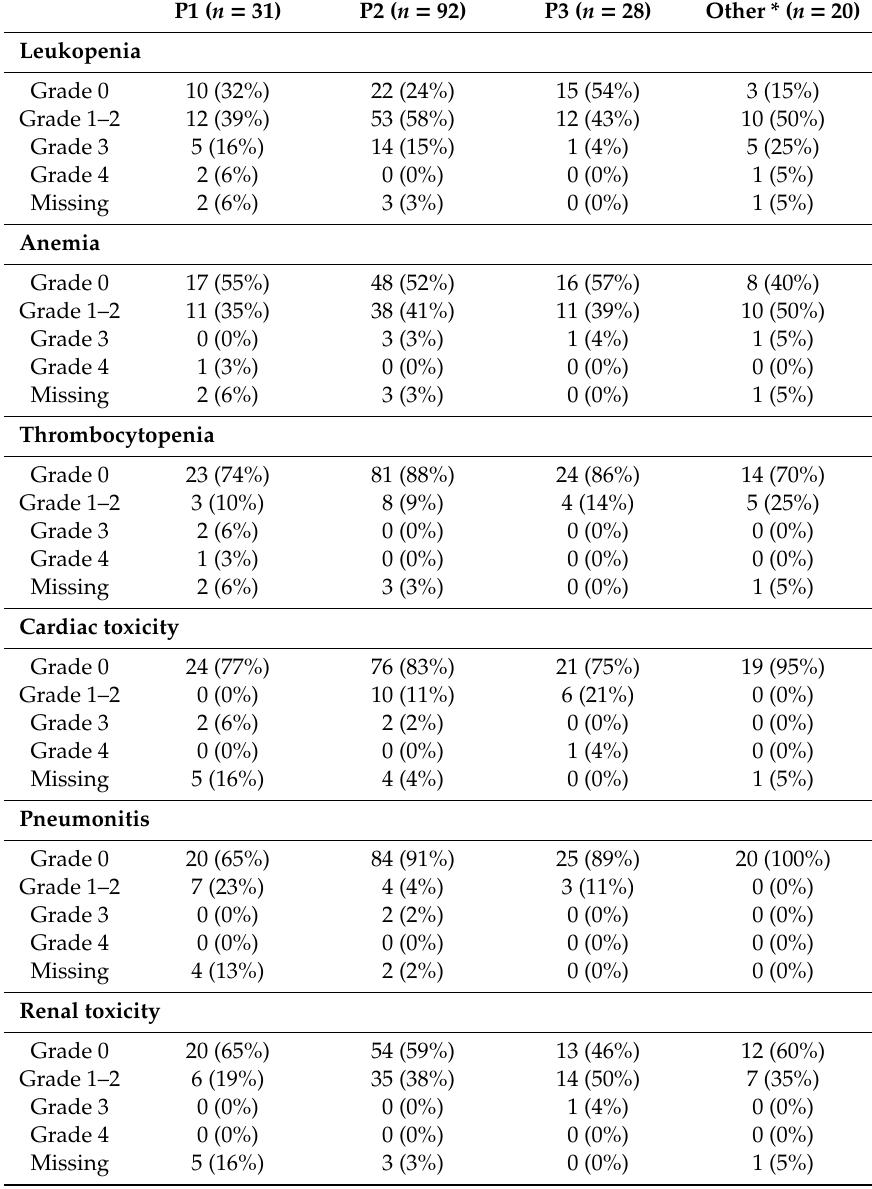
Table 3. Toxicity profiles of di ff erent chemotherapy